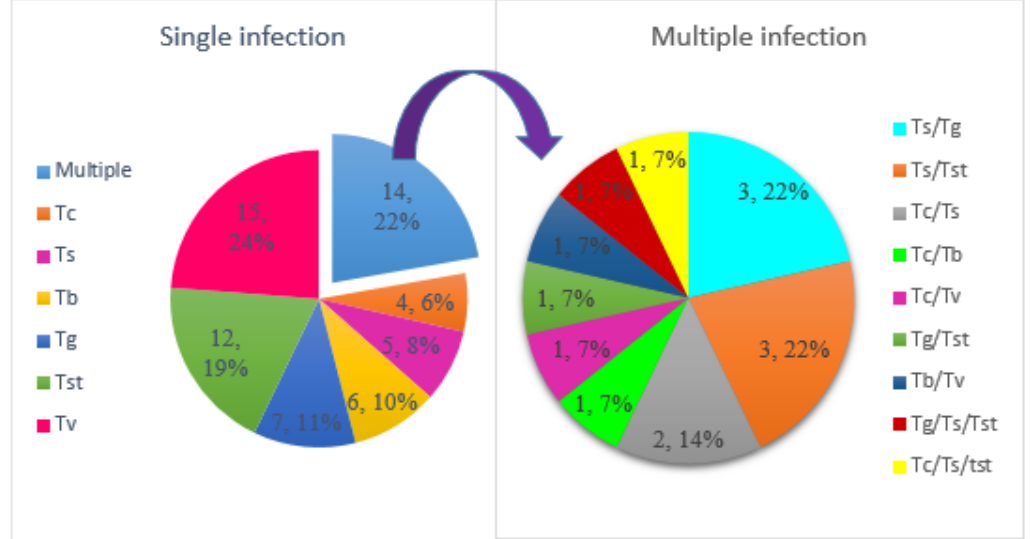
Figure 3. Distribution of single and multiple infections of trypanosome in tsetse flies. Note: Tc_ T.